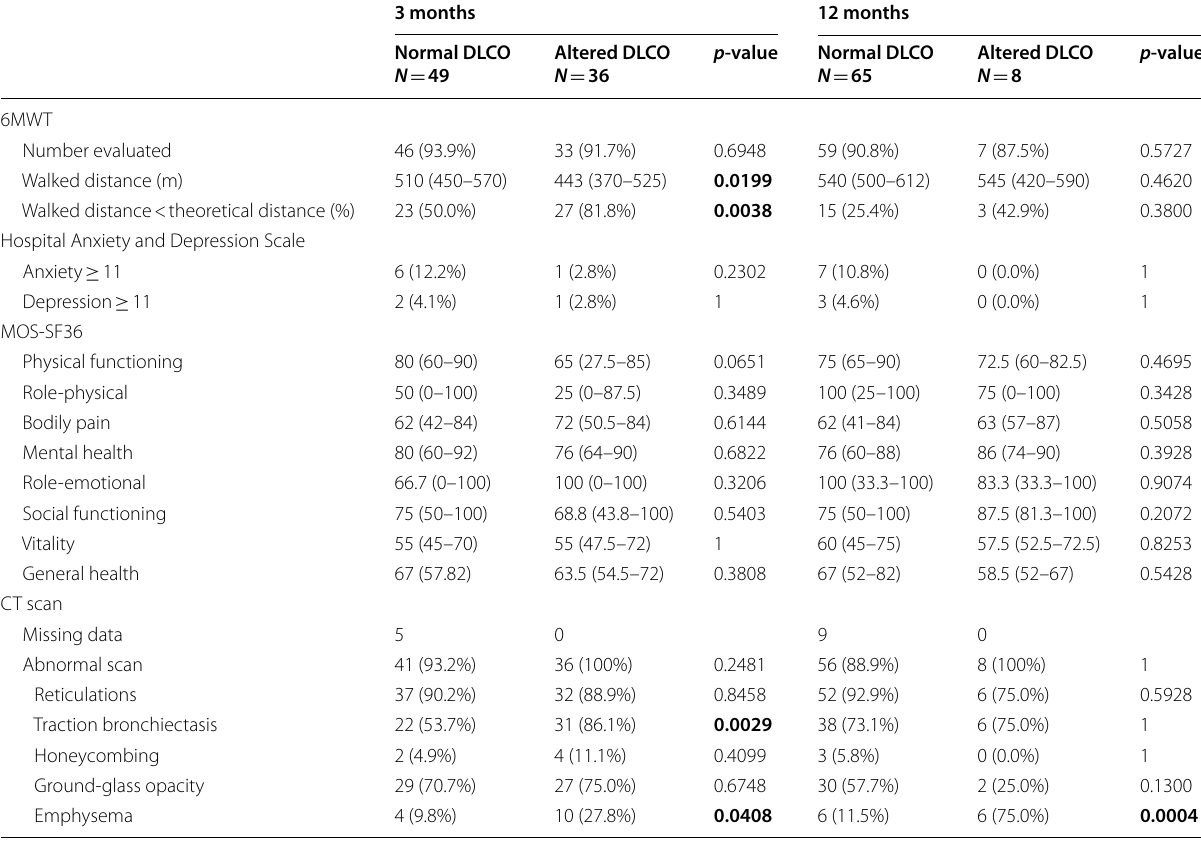
Values are presented as medians (interquartile ranges) or number of patients